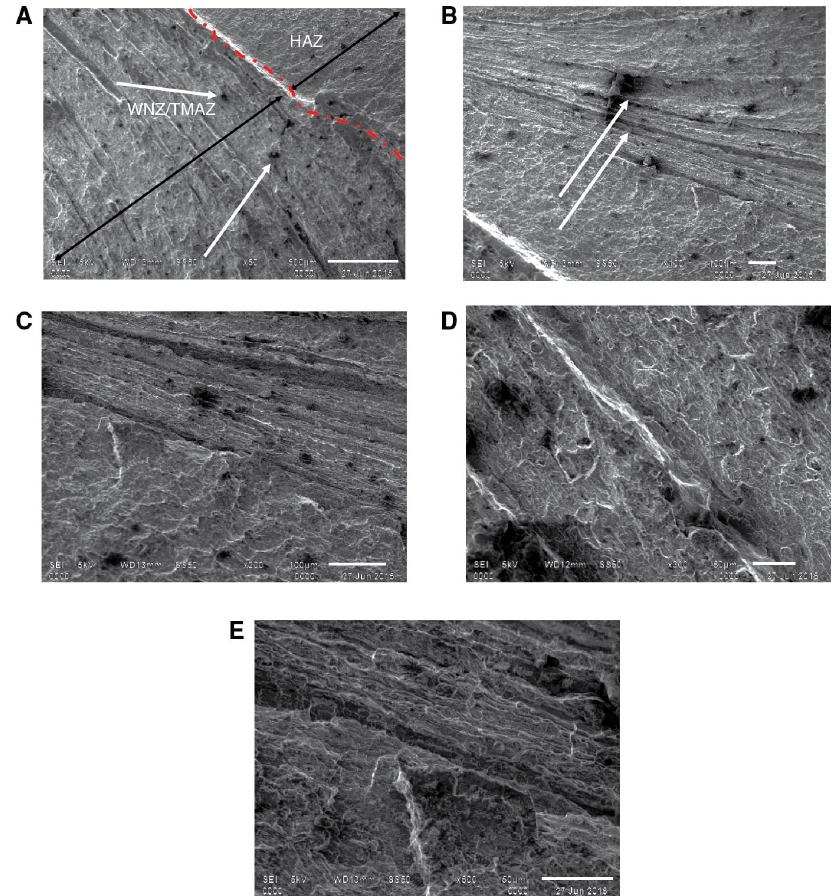
Figure 13: (A) Scanning electron micrograph of the weld zone (retreating side) at a magnification of 50×. (B) SEM of the weld zone (retreating side) at a magnification of 100×. (C) SEM of the weld zone (retreating side) at a magnification of 200×. (D) SEM of the weld zone (retreating side) at a magnification of 300×. (E) SEM of the weld zone (retreating side) at magnification of 500×.